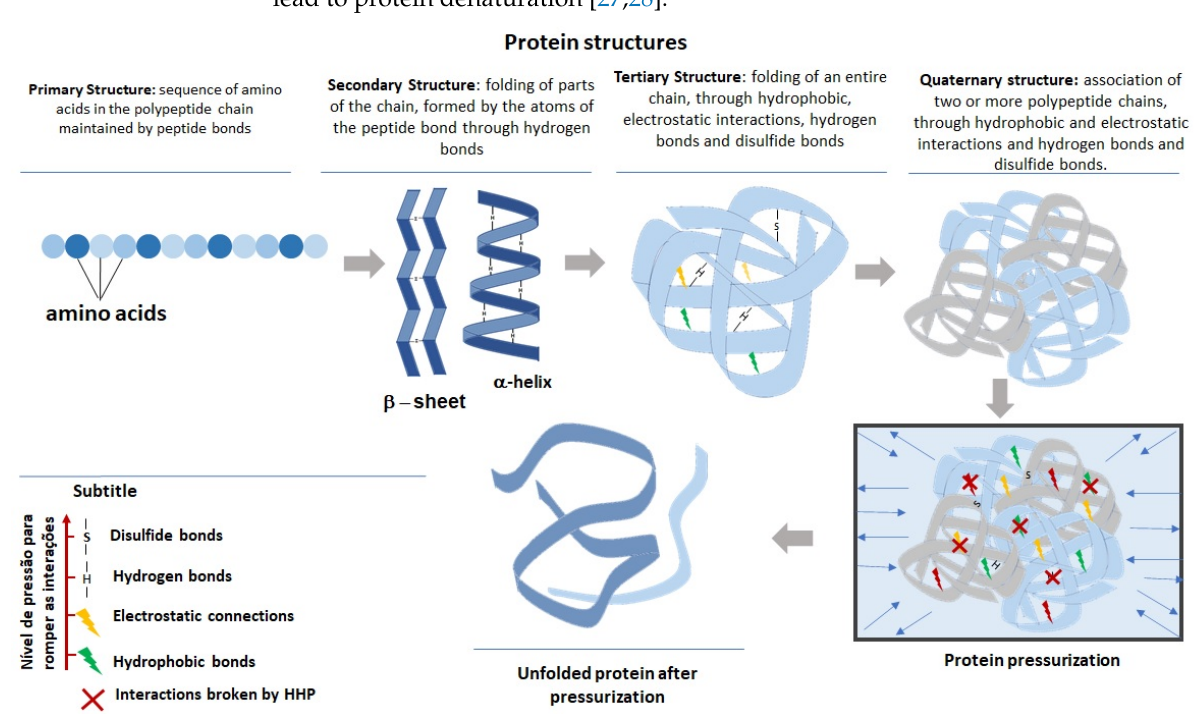
Figure 1. Different structural levels of proteins and the effect of high hydrostatic pressure on the structure and conformation of proteins.